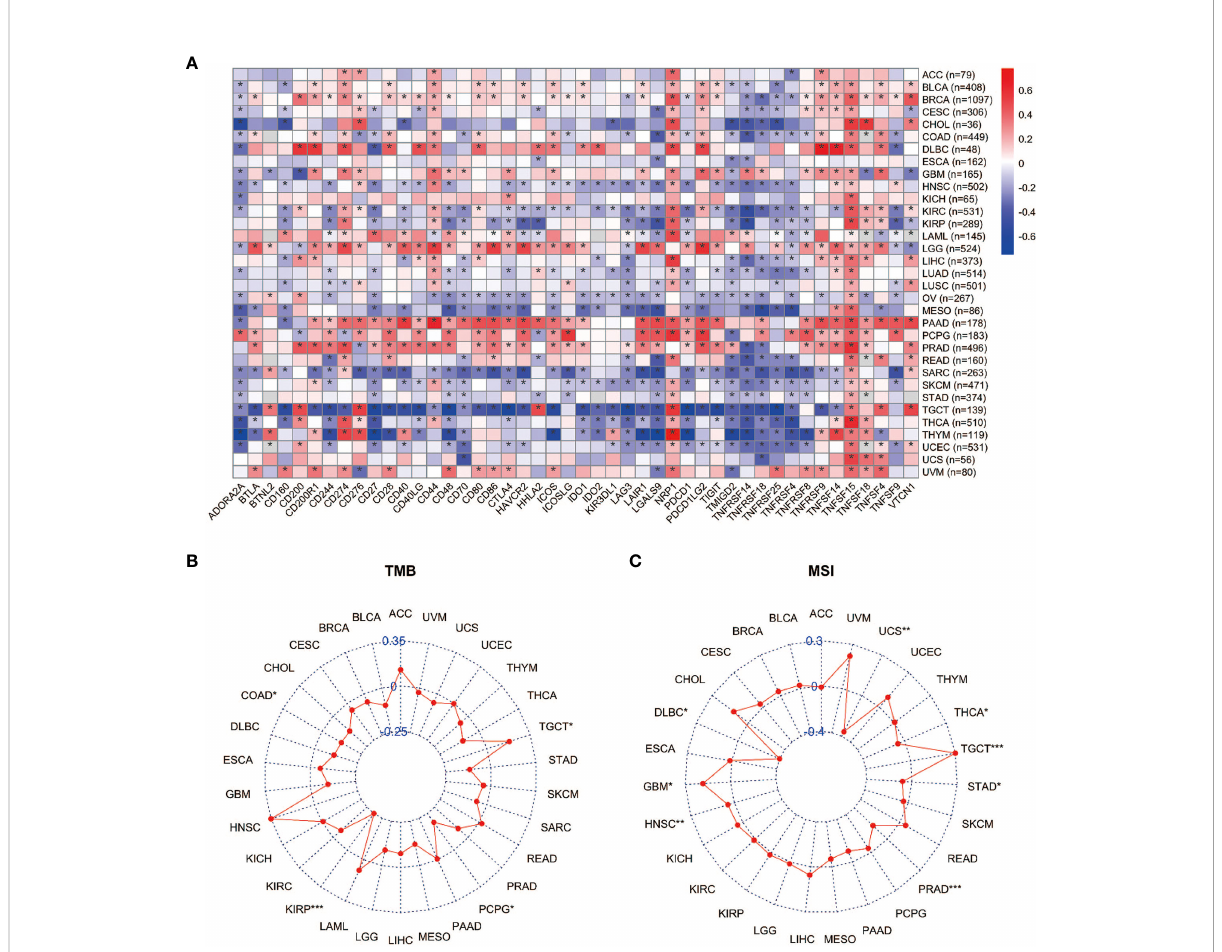
FIGURE 5 Correlation between expression of YAP1 and immune checkpoints, TMB, and MSI. (A) Heat map of correlation between YAP1 expression and 46 immune checkpoint regulators. * p < 0.05. (B, C) Correlation between YAP1 expression, TMB, and MSI. *** p < 0.001, ** p < 0.01, and * p <